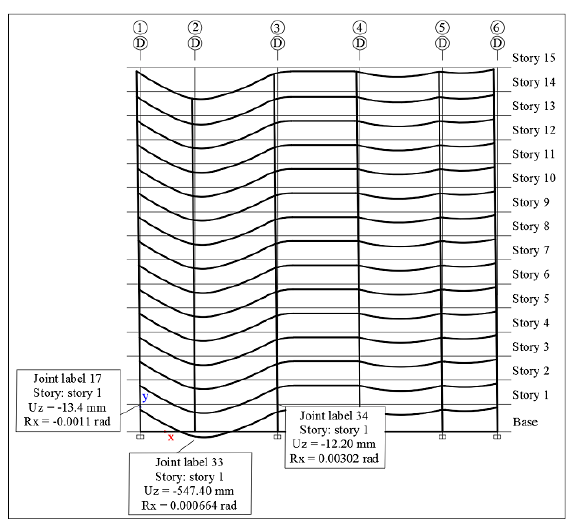
Figure 13. Displacement at notionally removed column D2 (part of grid line D) when moment frames are located at perimeters and along grid lines B, C, D, E, F and G (linear static analysis case 17). Table 9 shows deformation responses when column D3 is notionally removed.